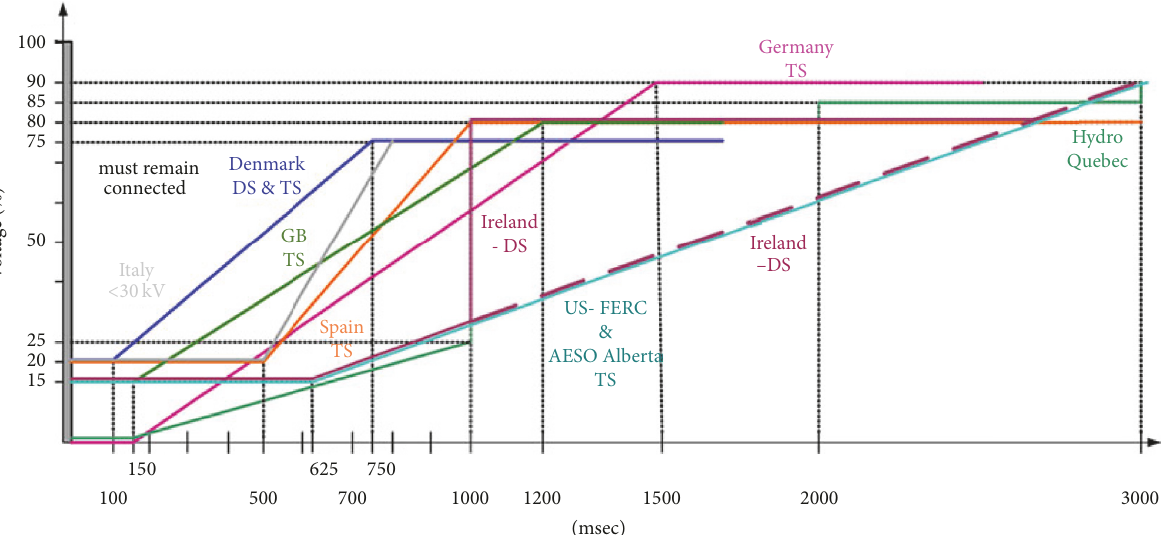
Figure 2: National grid codes